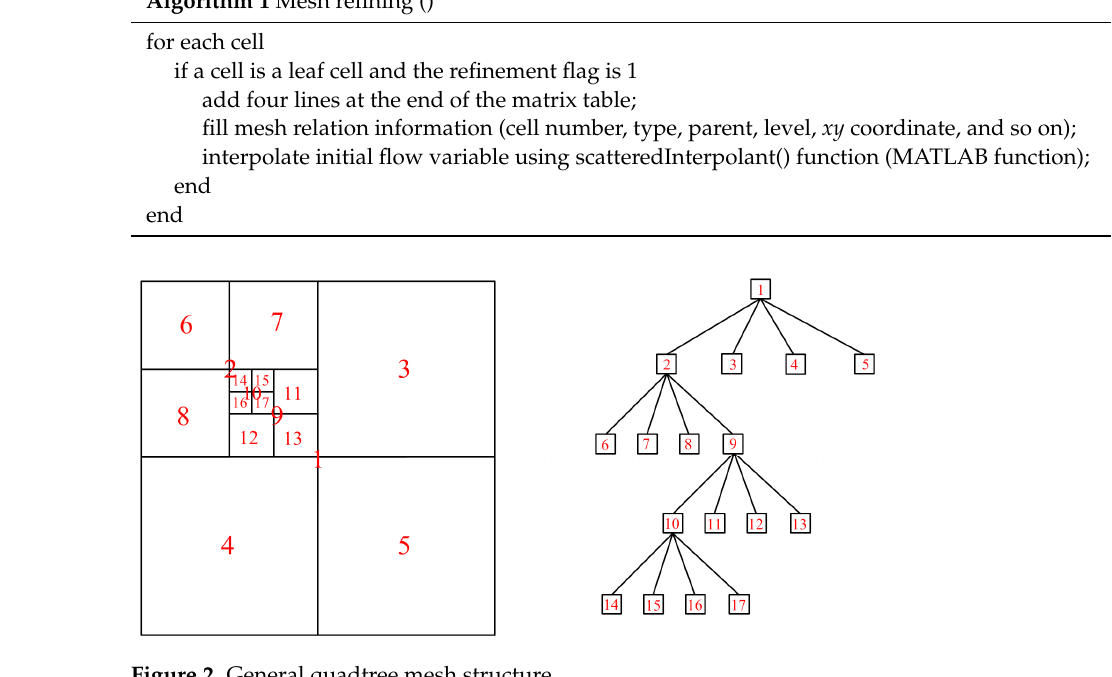
Figure 2. General quadtree mesh structure. Table 1. Matrix table of mesh storage.